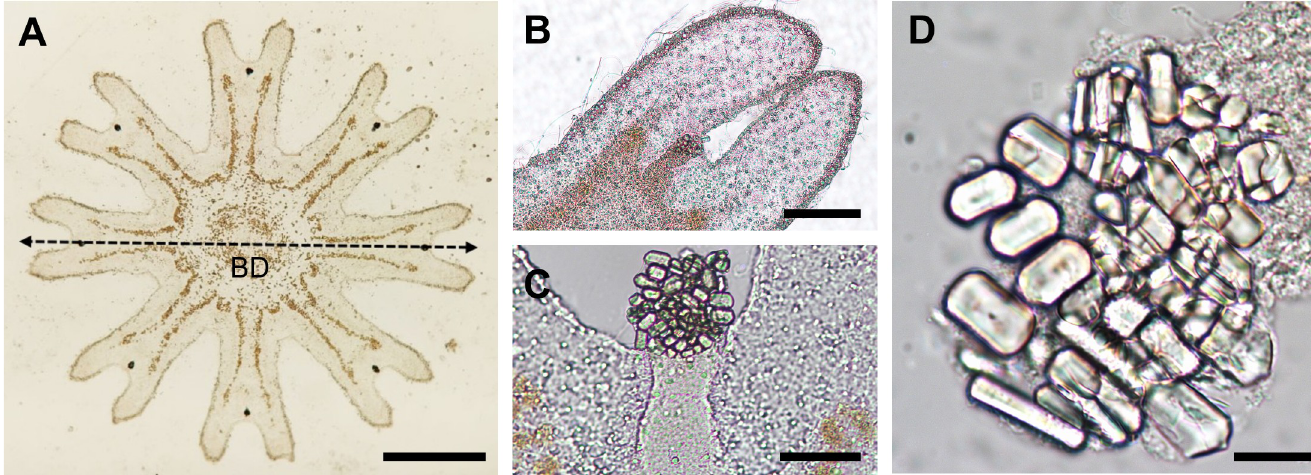
Fig 2. Cotylorhiza tuberculata ephyrae and statoliths measurements. A. Ephyrae of Cotylorhiza tuberculata . BD body diameter. Scale bar = 500 μ m. B. Ephyrae marginal lappets and rhopalium. Scale bar = 100 μ m. C. Rhopalium with statocyst containing statoliths inside. Scale bar = 50 μ m. D. Statoliths. Scale bar = 20 μ m.